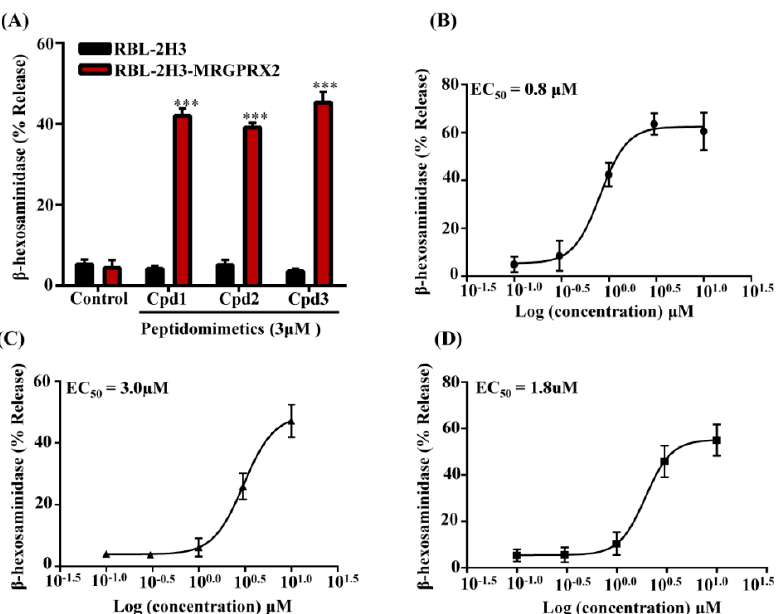
Figure 3. smHDPMs induce degranulation in RBL-2H3 cells expressing MRGPRX2. ( A ) Untransfected RBL-2H3 cells (RBL-2H3) and cells stably expressing MRGPRX2 (RBL-2H3-MRGPRX2) were exposed to vehicle (Control) or smHDPMs, (Cpd 1, 2, and 3, 3 µ M) for 30 min and percentage of β -hexosaminidase release was determined. Concentration–response curves for ( B ) Cpd 1, ( C ) Cpd 2, and ( D ) Cpd 3 were determined using RBL-2H3-MRGPRX2 cells. Data are presented as a mean ± SEM and are representative of three independent experiments in triplicate. Statistical significance was determined by two-tailed unpaired t-Test. *** indicates p value <